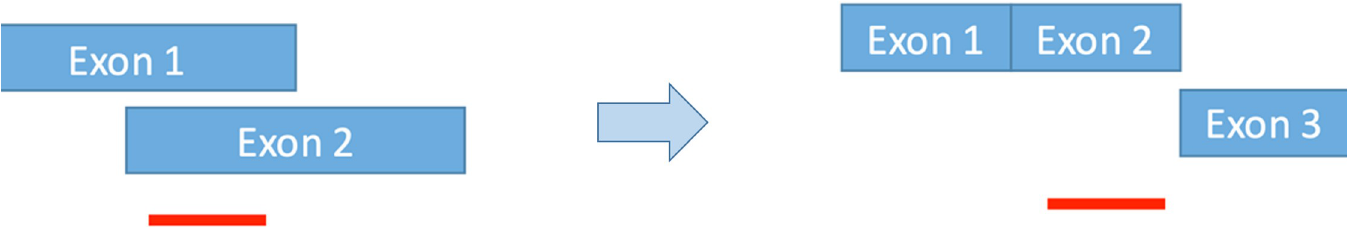
Fig 1. Overlapping exons from a gene annotation file (left) are converted to non-overlapping exons (right). The read type of a RNA-seq read (the red bar) may be ambiguous in the original annotation file but is unique in our converted file.